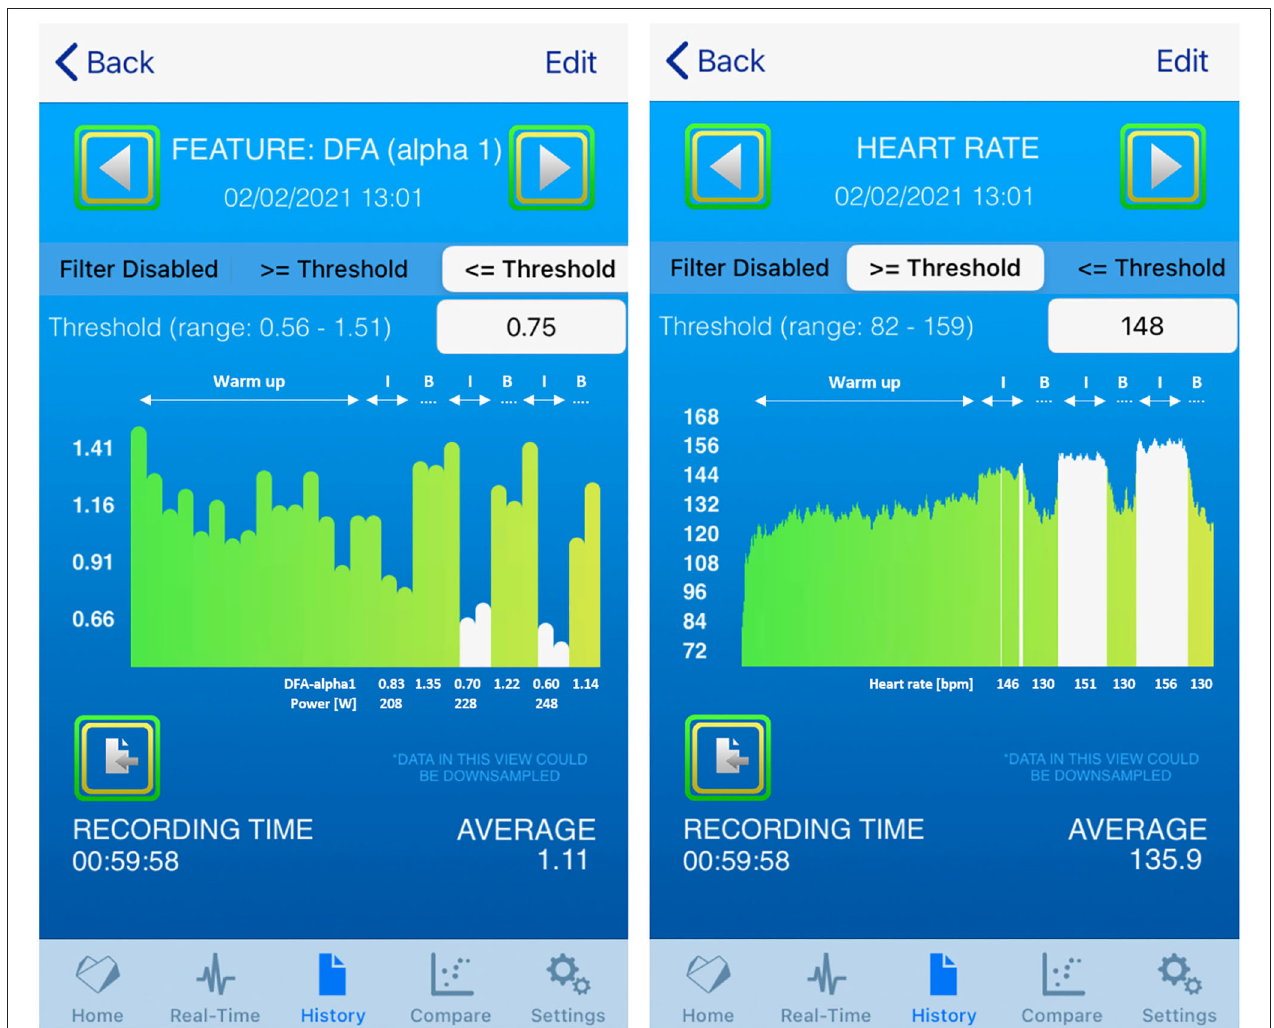
FIGURE 4 | History view of the 1h training session and included values (left: DFA-alpha1 with power values, right: HR); I: 6min interval, B: HR based active recovery period; DFA-alpha1 values displayed in white are the average of the two data points taken at 4 and